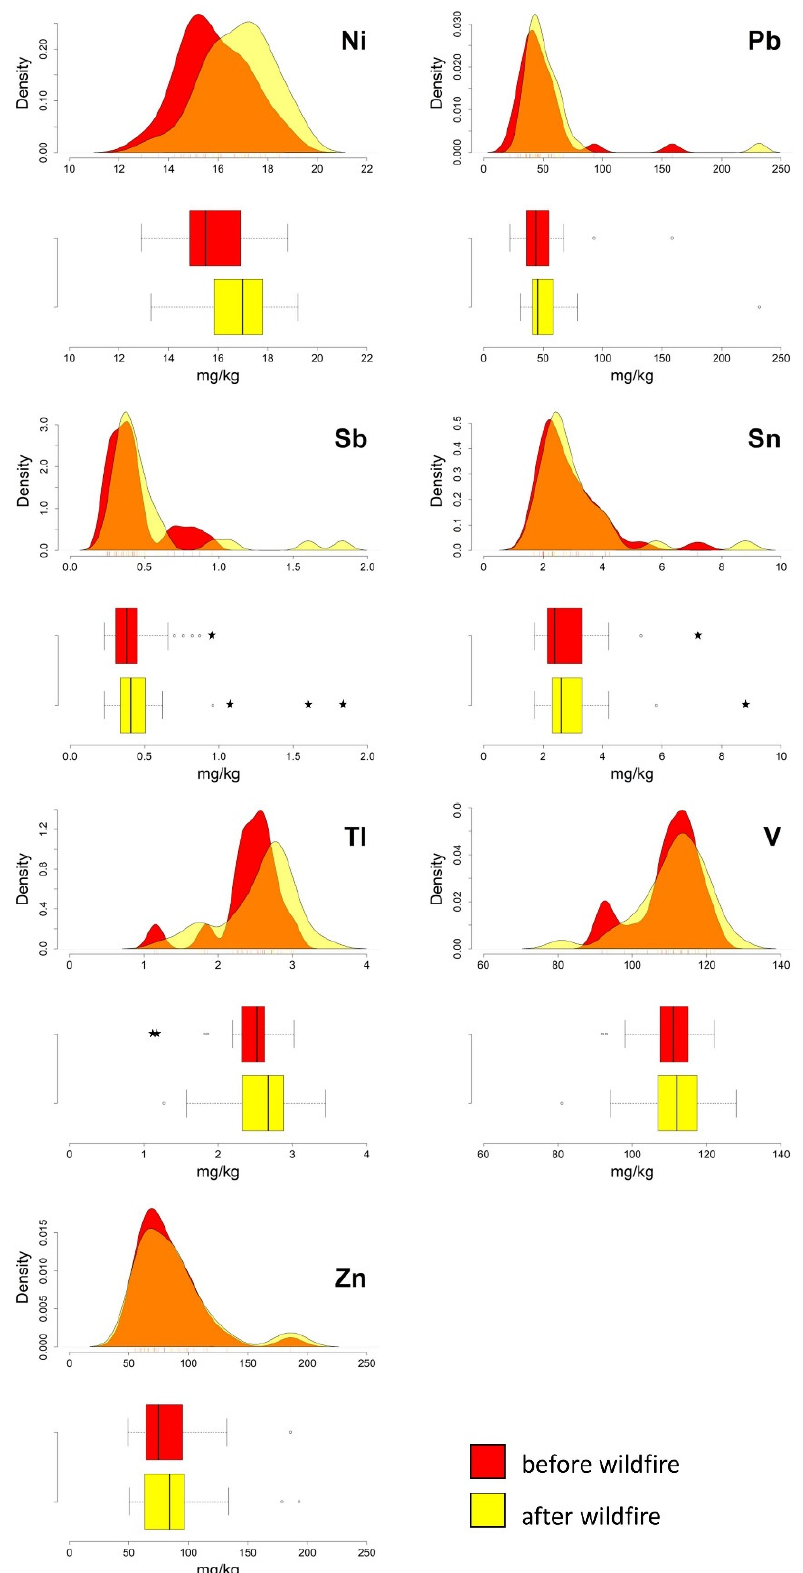
Figure 6. Vesuvian area. Boxplots and density curves of selected PTEs (Ni, Pb, Sb, Sn, Tl, V and Zn) in the soil before and after the fire event. Circles and pentagrams represent outliers and extreme values,